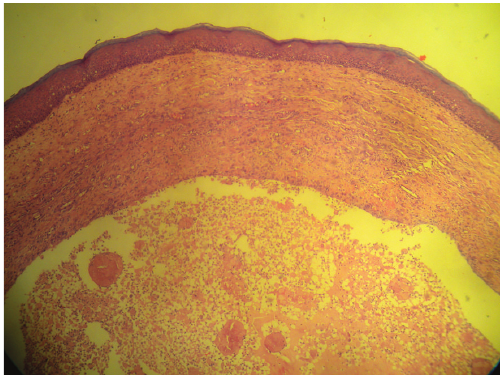
Figure 3: Histopathological analysis of the excised tissue showing thestratifiedsquamousepitheliumwithunderlyingmucoidmaterial and inflammatory cells.